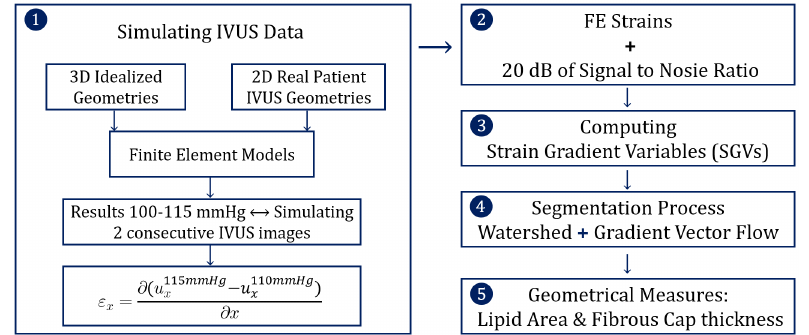
Figure 1. Scheme of the five steps that define the